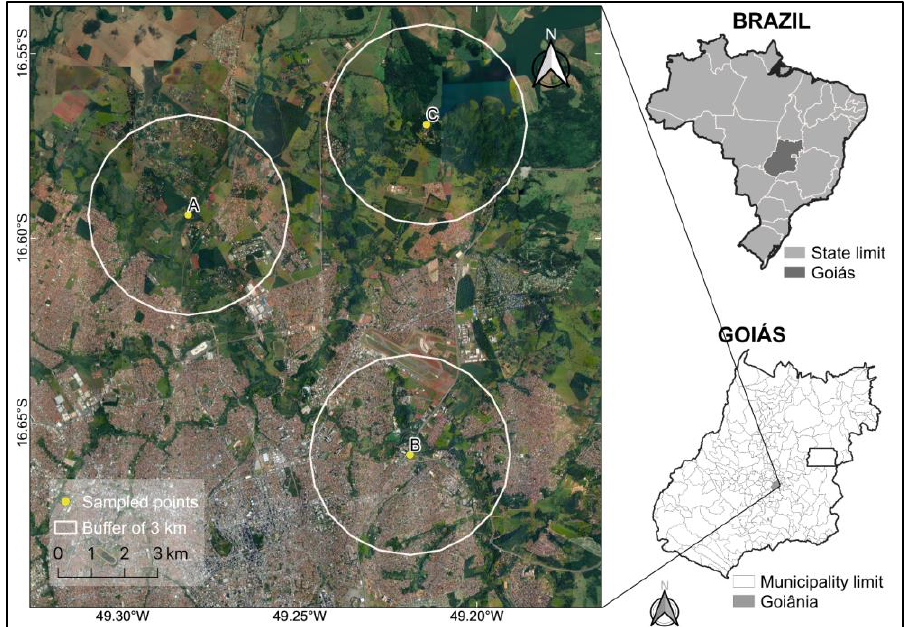
Figure 1. Sites where animals were sampled in the municipality of Goiânia, state of Goiás, midwestern, Brazil. A= school farm of the Veterinary and Animal Science School (EVZ) of the Federal University of Goiás and to the neighborhoods close to the EVZ; B= Vila Morais neighborhood and surrounding area; C= peri-urban and rural area close to the dam of the Ribeirão João Leite reservoir.